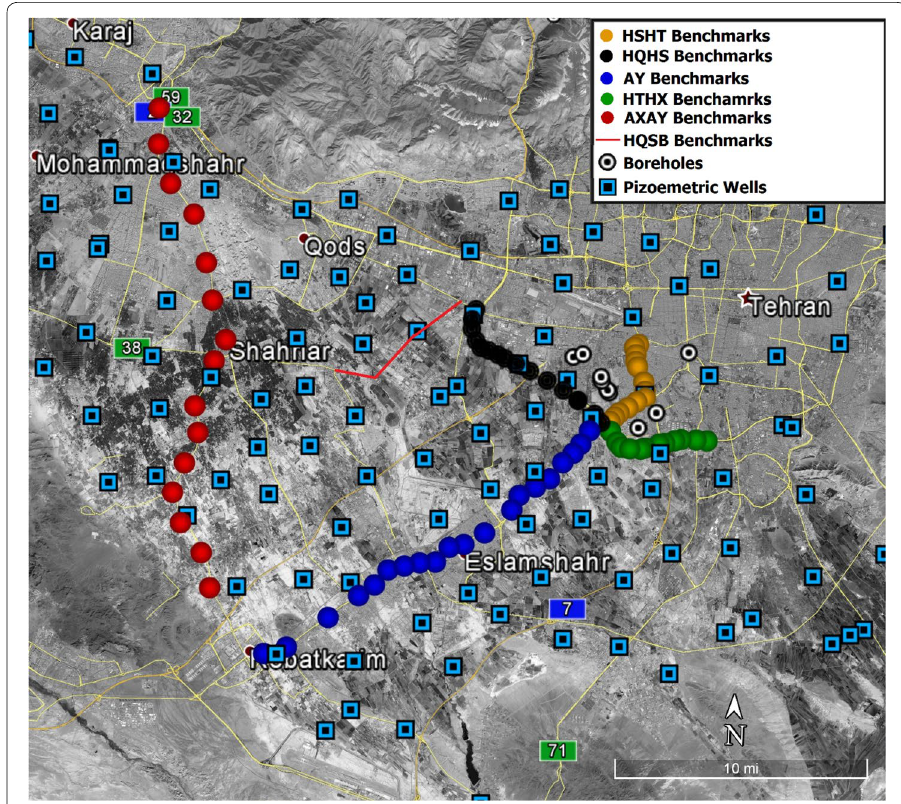
Fig. 2 Geographical distribution of the compiled